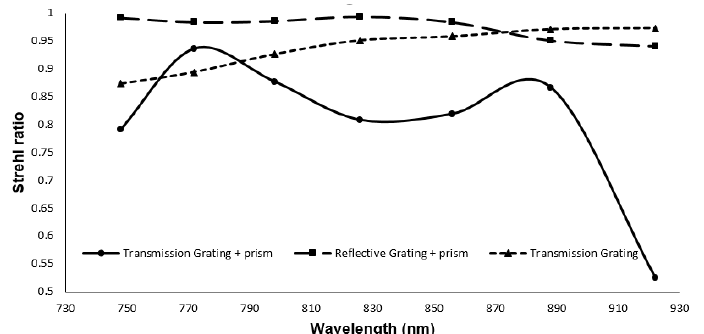
Figure 9. Comparison of the Strehl ratio of the linear spectrometer based on transmission grating and reflective